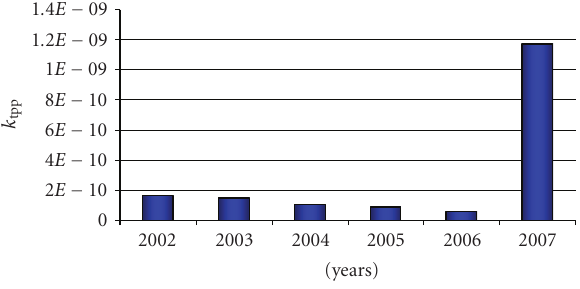
Figure 5: Values of k FCT for reference FA number